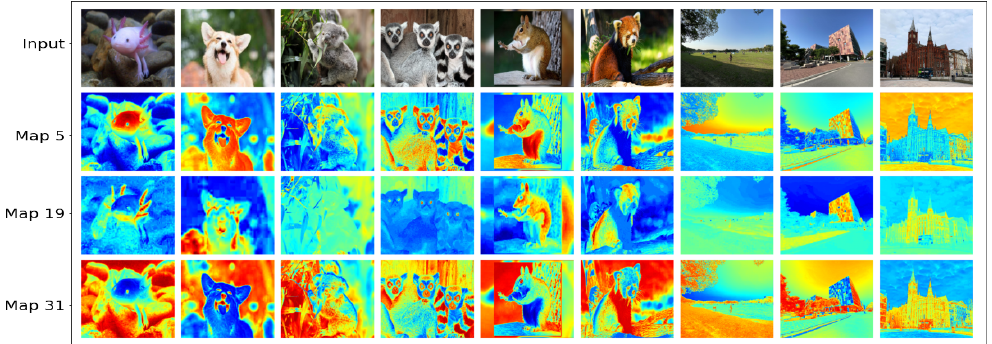
Figure A2. Visualization of three different feature maps in